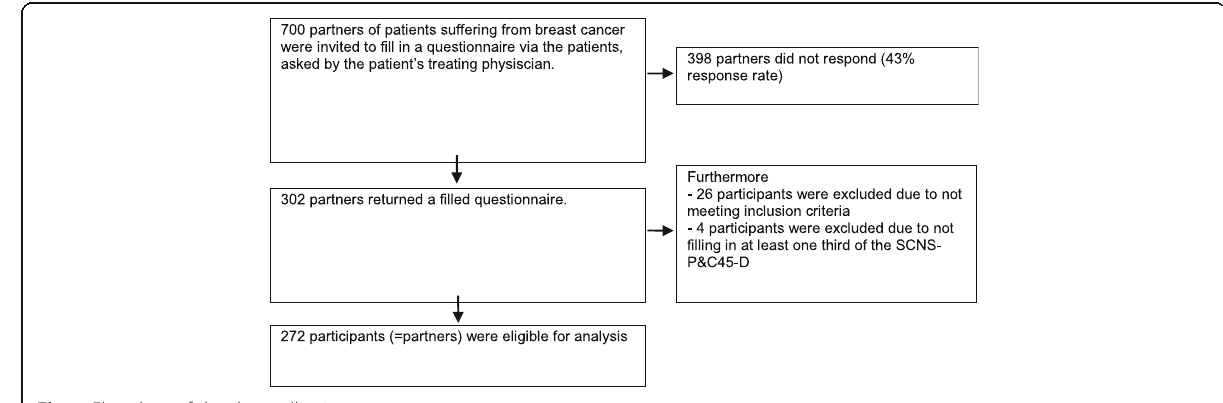
Fig. 1 Flowchart of the data collection